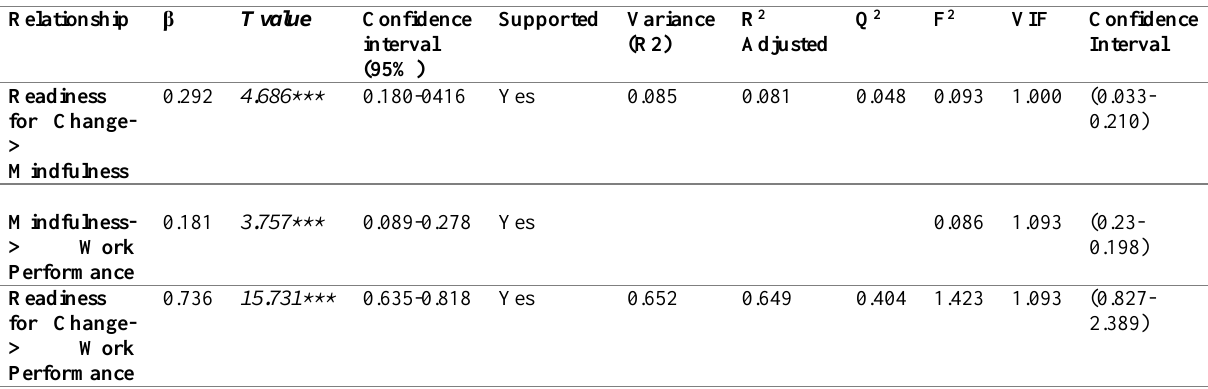
Table 3: Structural model